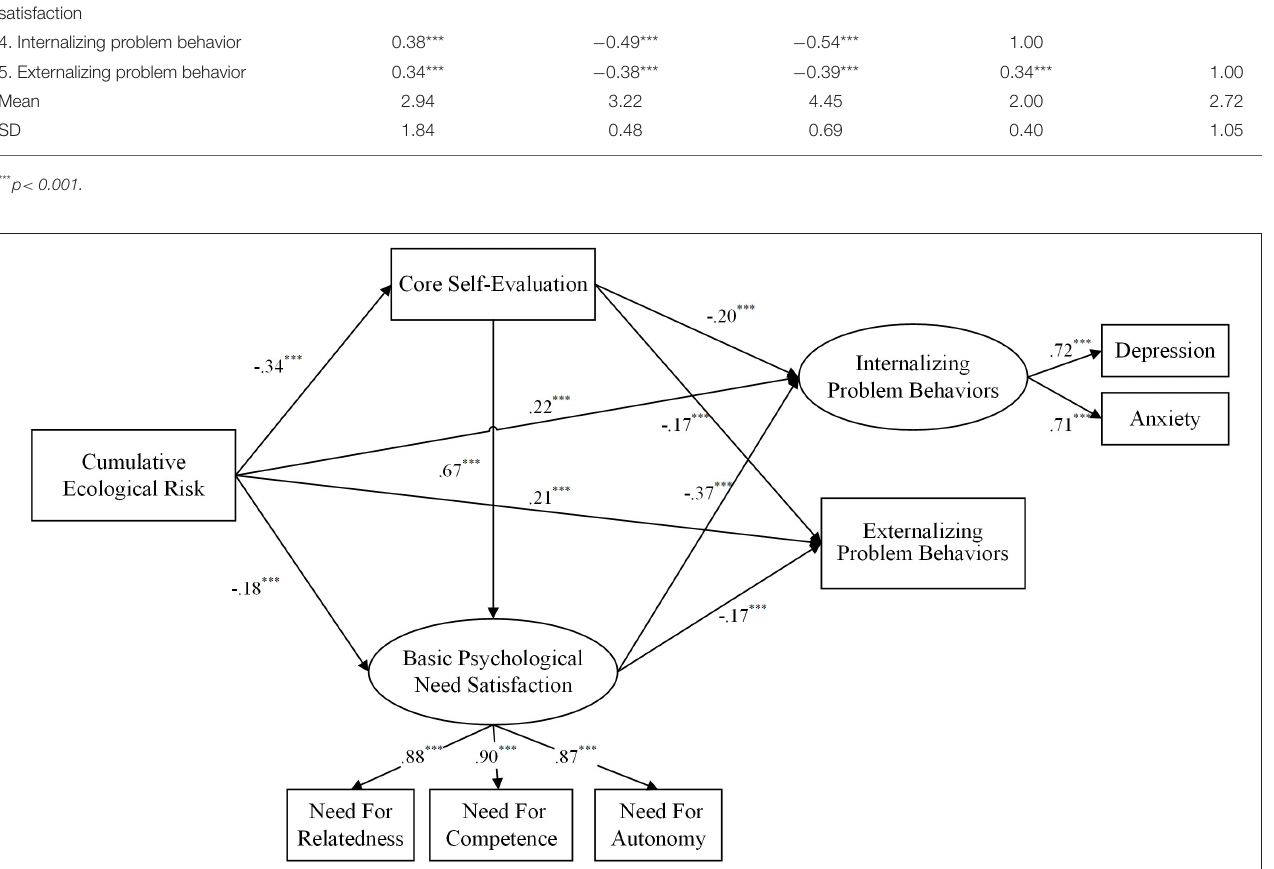
FIGURE 1 | Final structural model with standardized estimated (Model 3). Need for relatedness, need for competence, need for autonomy, depression, and anxiety are dimensions of their corresponding latent variables. For the purpose of brevity, gender and age were included as control variables in M 3 but not shown in the figure. *** p <